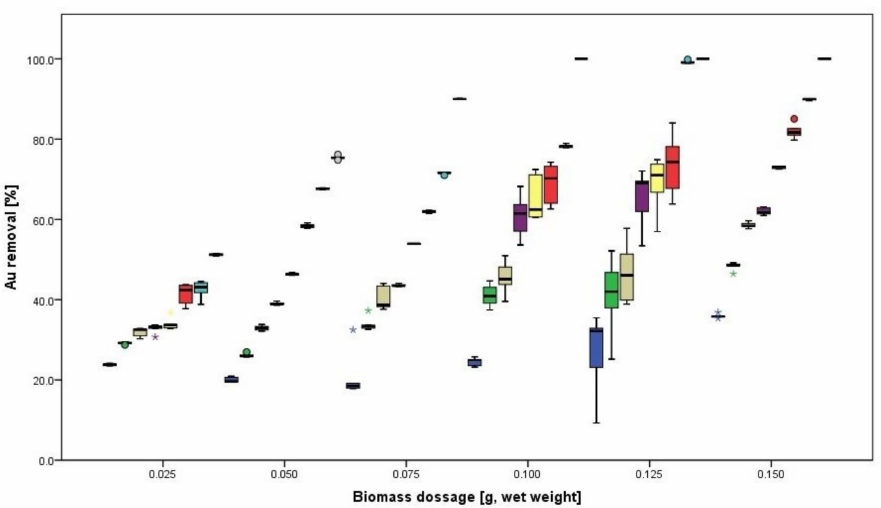
Figure 16. Au removal by different quantities (wet weight) of Cladosporium cladosporioides pellets and at different contact times. (cid:4) : 1 h; (cid:4) : 2 h; (cid:4) : 3 h; (cid:4) : 4 h; (cid:4) : 5 h; (cid:4) : 6 h; (cid:4) : 12 h; (cid:4) : 24